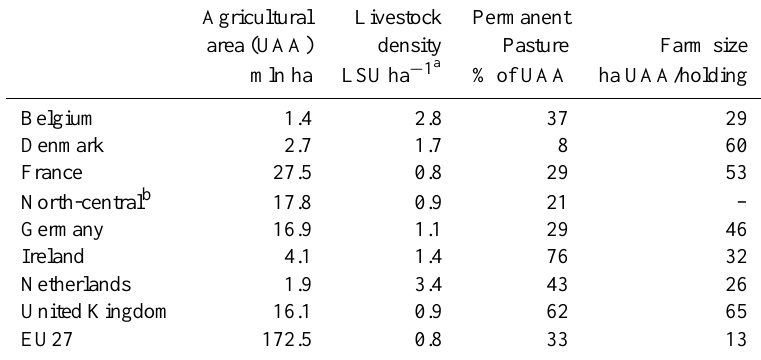
Table 4. Main characteristics of agricultural sector in northwestern member states of the EU in 2007 (Eurostat,